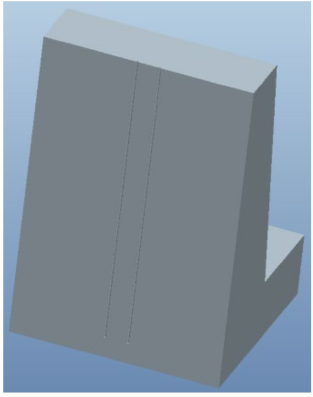
Figure 9. Model diagram.